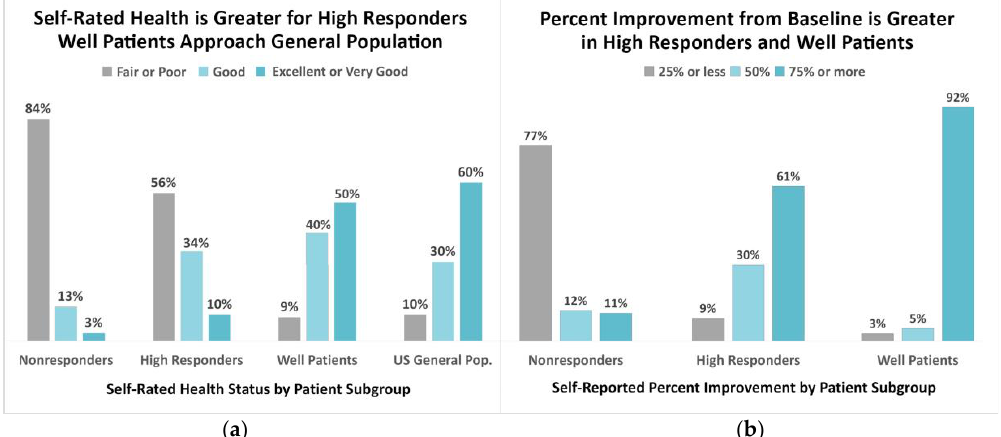
Figure 2. ( a ) Self-rated health is greater in high responders and well patients, with well patients approaching the general population. ( b ) Percentage of improvement from baseline is also greater in high responders and well